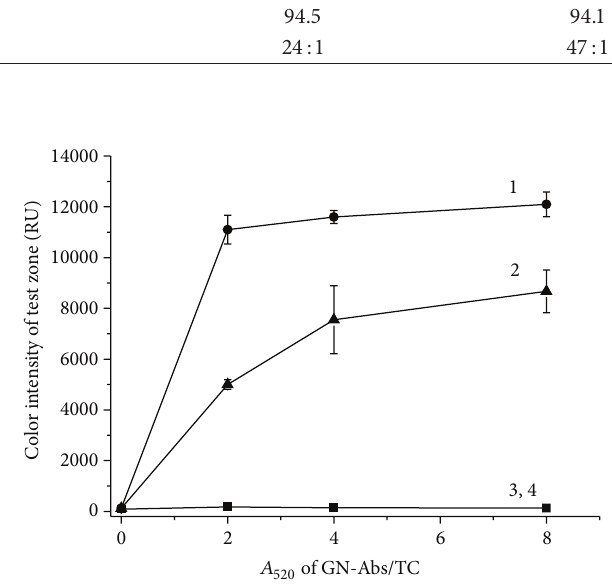
Figure 7: Binding of IgG-GNP conjugates (1 and 3—conjugate of composition 47 :1; 2 and 4—conjugate of composition 23.5 : 1) with the fb -BSA conjugate (curves 1 and 2) and standard BSA preparation (curves 3 and 4) on the immunochromatographic